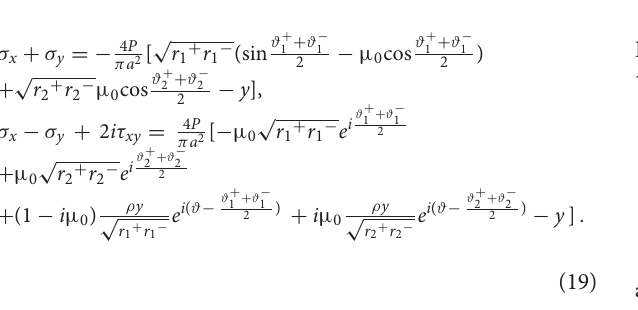
as well as maximum tangential stress